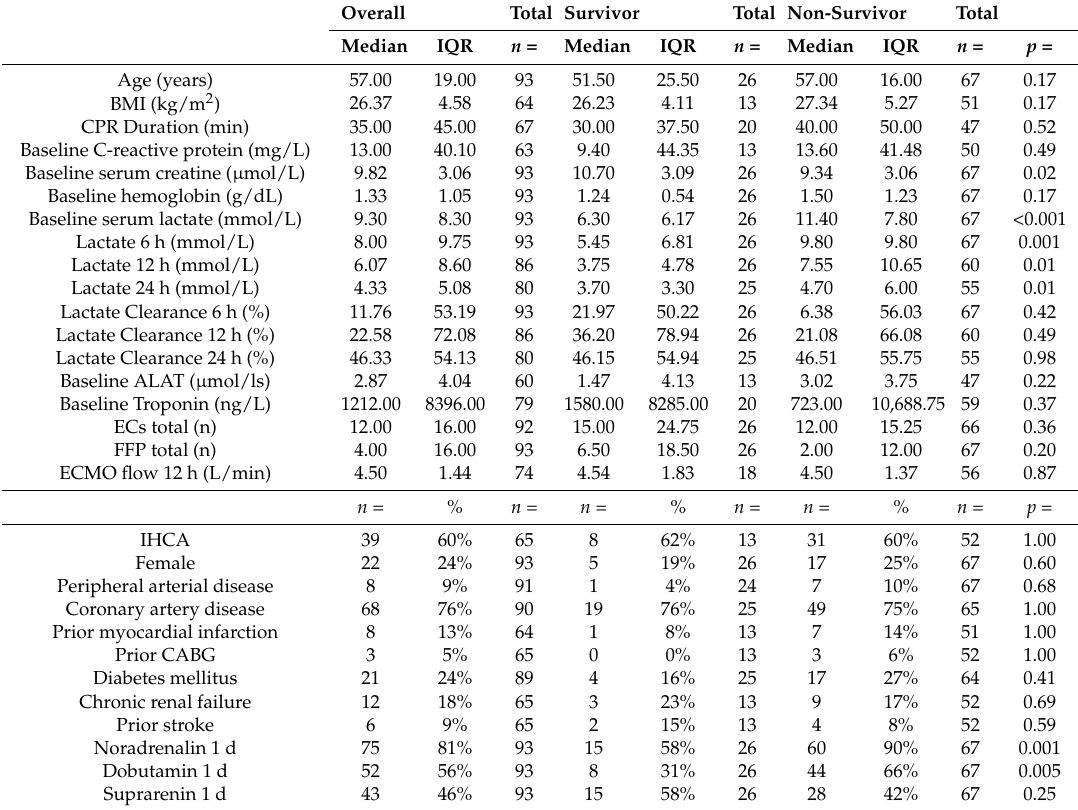
Table 1. Baseline characteristics of the study